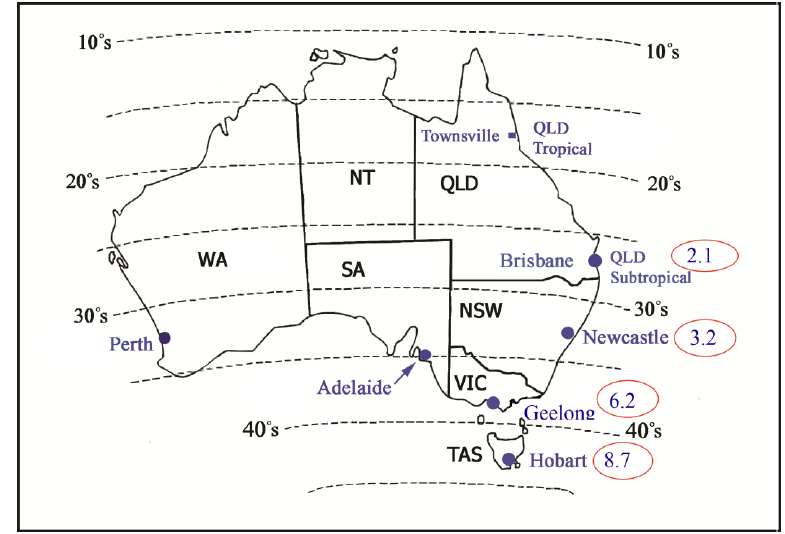
Figure 2. Death rate from lung cancer and consumption of tobacco and cigarettes over time in the United Kingdom (redrawn using data from [17]).